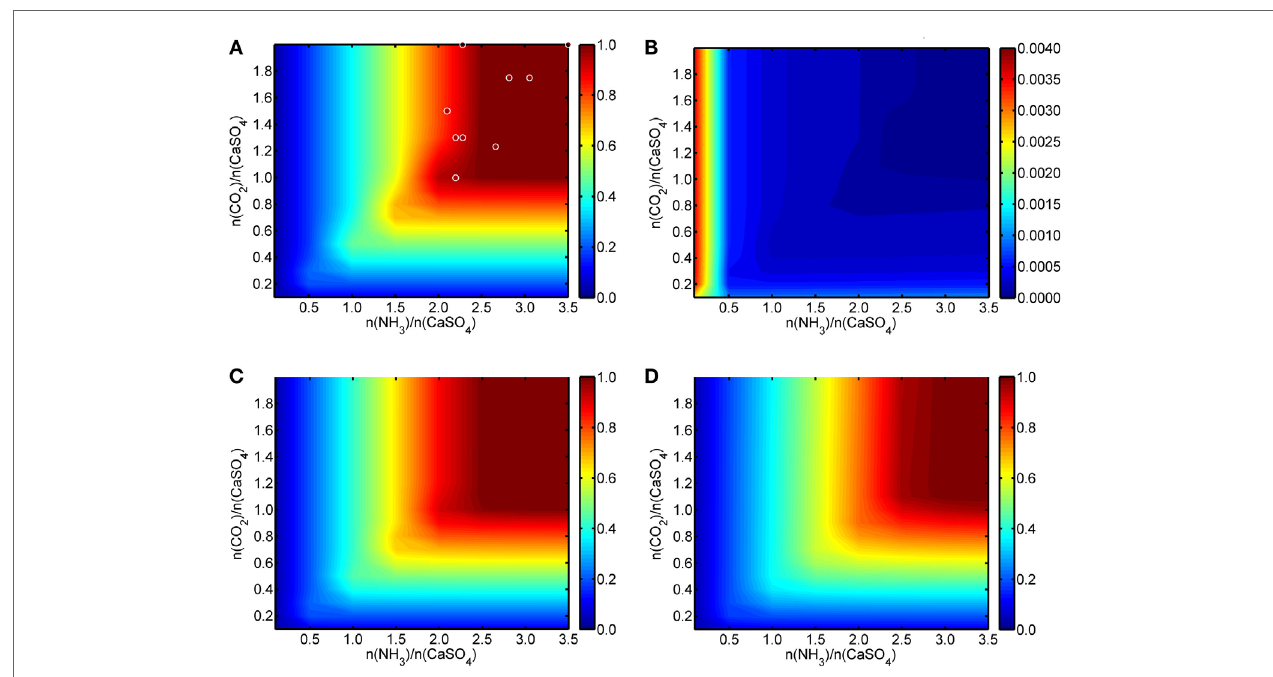
FigUre 2 | (a) Conversion of solid CaSO 4 ·2H 2 O to solid CaCO 3 and (B) to Ca 2 + (aq) at 20°C. (c) Conversion of solid CaSO 4 ·2H 2 O to solid CaCO 3 at 45°C and (D) at 80°C. Figures are drawn as functions of initial NH 3 /CaSO 4 and CO 2 /CaSO 4 molar ratios with modeling results (color bar on the right) obtained from HSC Chemistry software. Dots in (a) represent examples of the experimental results obtained during the course of the work, the color indicating the obtained